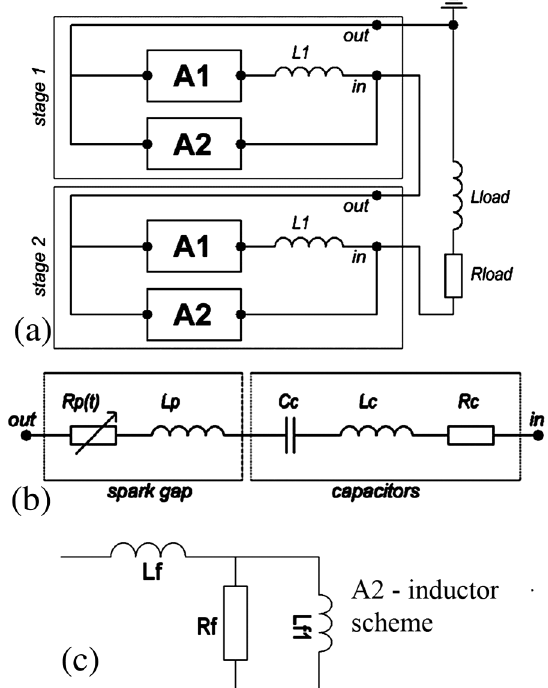
FIG. 6. Simulation network: (a) electrical scheme of the ca- pacitor block ( C C , L C , and R C are capacitor parameters; R P ð t Þ and L P are electrical parameters of the switch); (b) equivalent electrical scheme for the two LTD-20 stages assembly; (c) equivalent scheme for the stage inductor